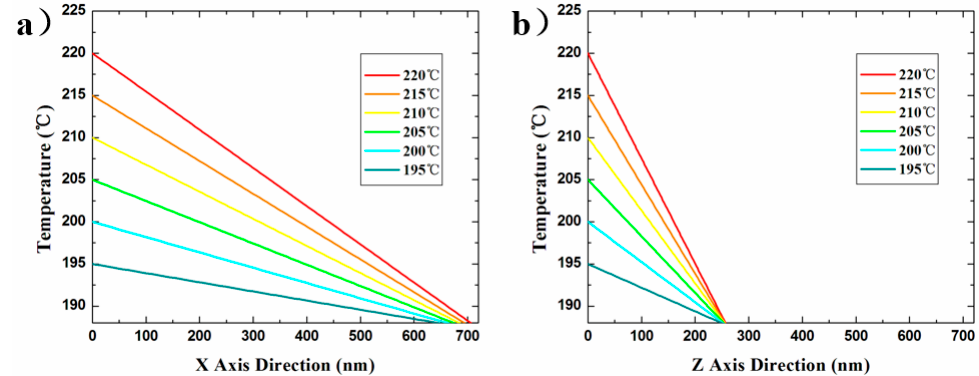
Figure 6. Calculated steady-state temperature profiles of ( a ) x axial and ( b ) z axial direction from the heated tip to the sample surface in the pyramid air gap. The preset tip temperature expressed in di ff erent colors is from 195 to 220 ◦ C. The temperature is expressed as a function of the distance away from the tip, and the slope of the curve represents the temperature gradient at any point on